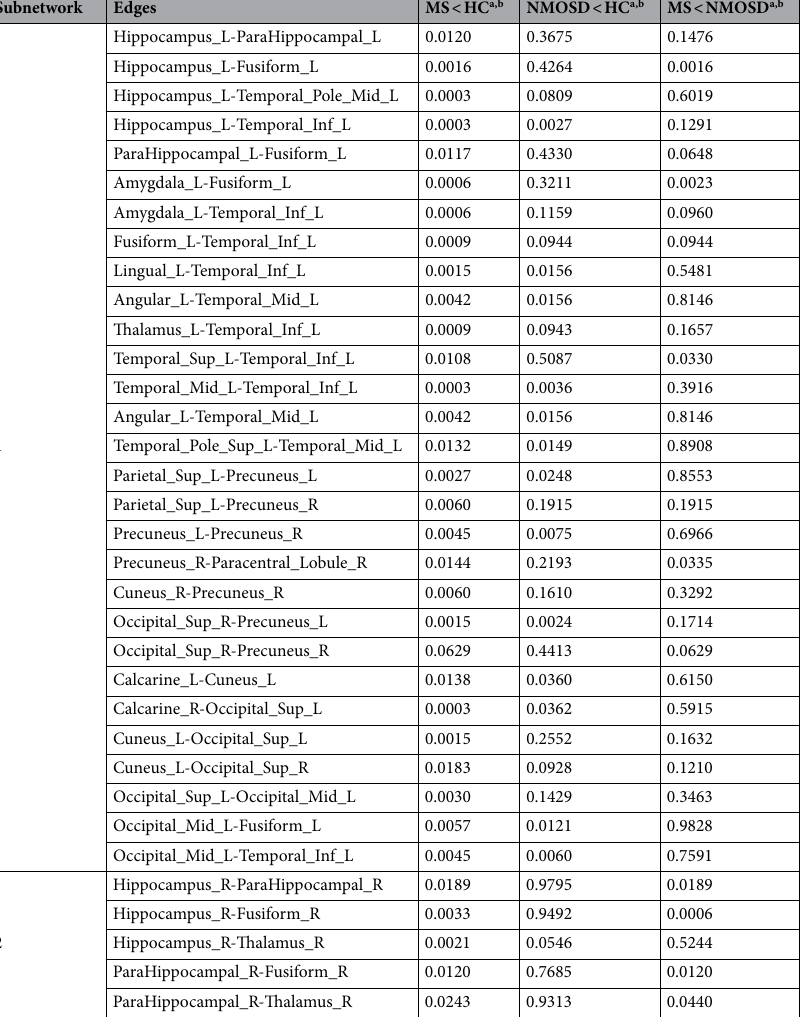
Table 4. The post-hoc test result for the identified subnetworks through network-based statistics. MS multiple sclerosis, NMOSD neuromyelitis optica spectrum disorders, HC healthy controls, Temporal_Pole_Mid Temporal pole: middle temporal gyrus, Temporal_Inf Inferior temporal gyrus, Temporal_Mid Middle temporal gyrus, Temporal_Sup Superior temporal gyrus, Temporal_Pole_Sup Temporal pole: superior temporal gyrus, Parietal_Sup Superior parietal gyrus, Occipital_Sup Superior occipital gyrus, Occipital_Mid Middle occipital gyrus, R right; L left. a A < B, decreased edges in A relative to B. b FDR adjusted p values of post-hoc tests